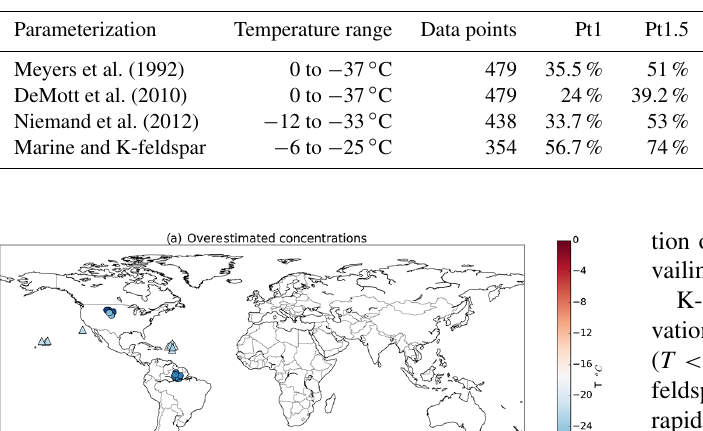
Table 1. Statistical performance of the different parameterizations. Pt1 and Pt1.5 are the percentages of data points reproduced within an order of magnitude and 1.5 orders of magnitude in the temperature range of every parameterization. The number of data points used for calculating these values is shown under the data points column. The values with ∗ show the same calculation but include data points outside the temperature range of the parameterizations. These values give an idea of the performance that you would expect if you extrapolate the parameterizations in a climate model. The values with ∗∗ are for data points within the smallest temperature range shared by the four parameterizations ( − 12 to − 25 ◦ C). The correlation coefficient has been calculated with the logarithm of the values as INP concentrations vary logarithmically with temperature.